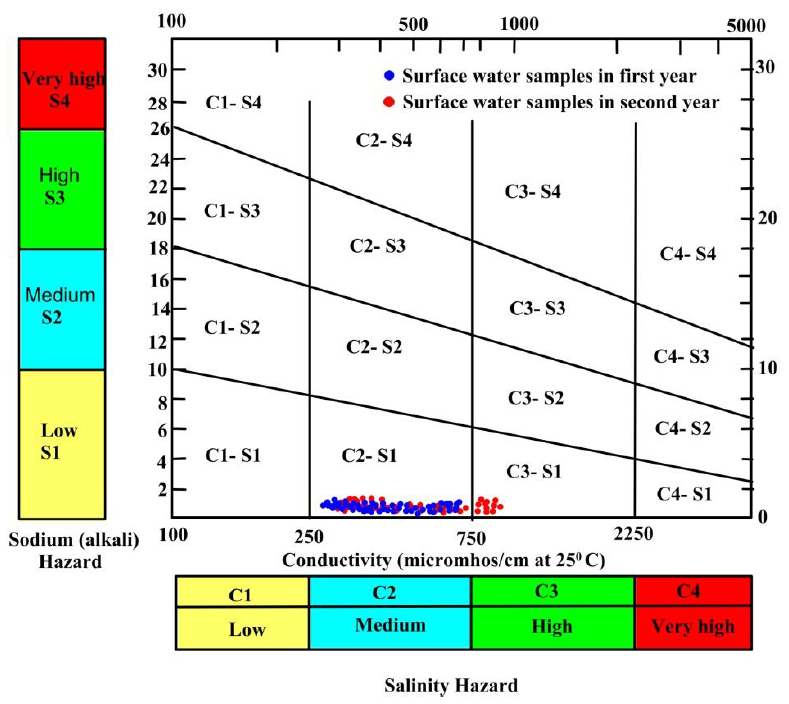
Figure 8. The United States Salinity Laboratory USSL Diagram to assess surface water quality for irrigation in two years.